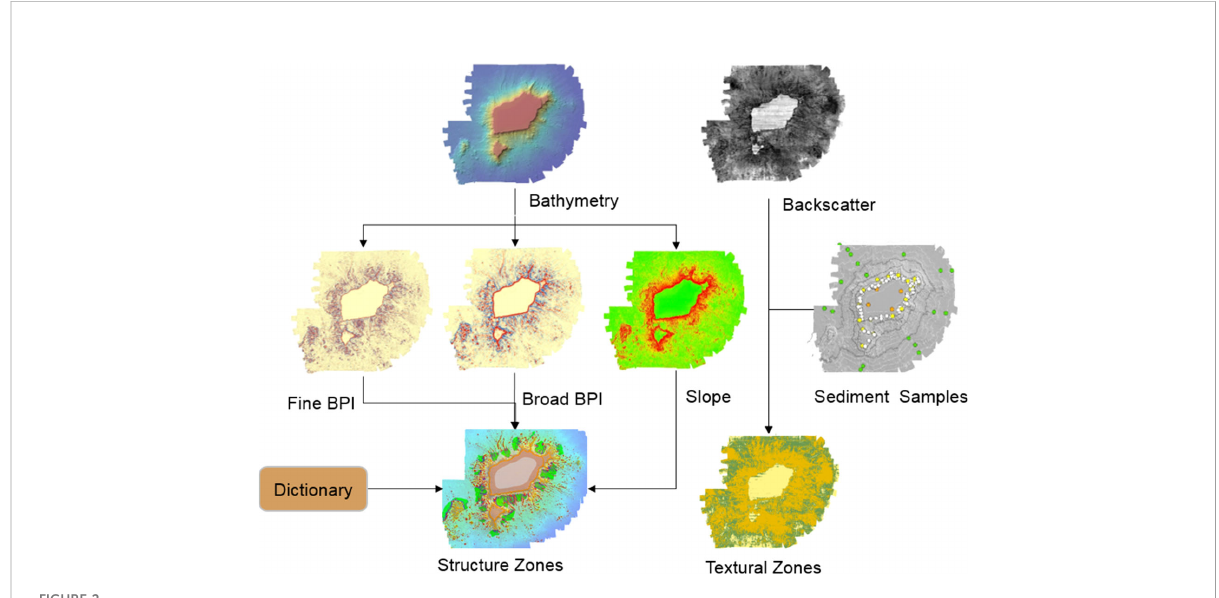
FIGURE 2 Flow chart of the structural zone and textural zone classi fi